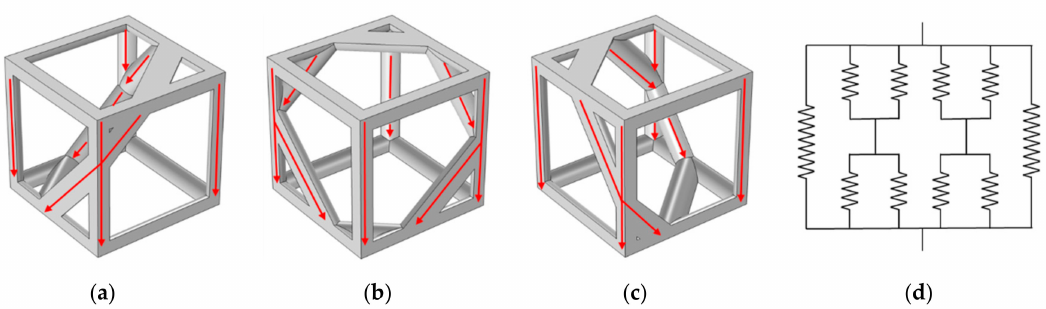
Figure 12. Schematic of the equivalent thermal cycle and the effects of different orientations of the RV2 structure on the heat transfer path: ( a ) OX; ( b ) OY; ( c ) OZ; ( d ) equivalent thermal